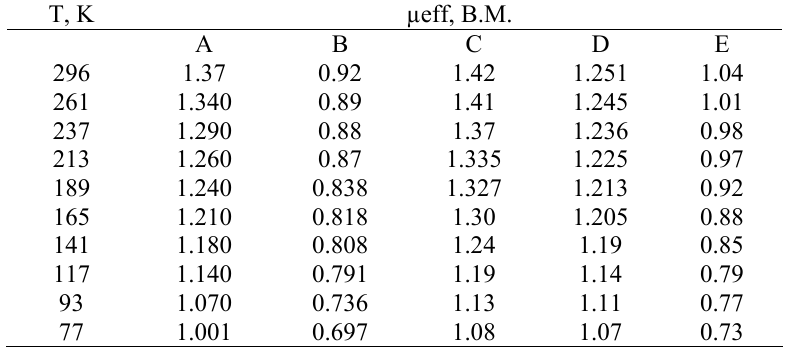
Table 1. Temperature dependent magnetic moment data of metal